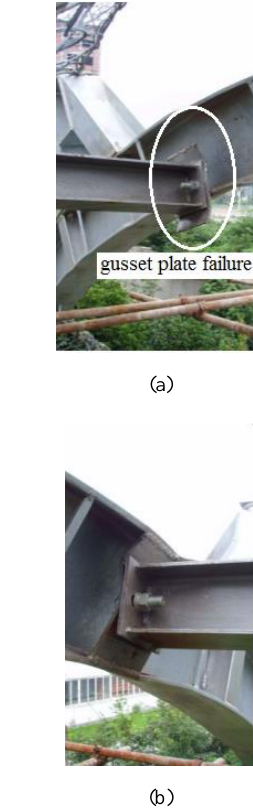
Fig. 9. (a) One of the gusset plates failure; (b) The detail deformation at the gusset plate.